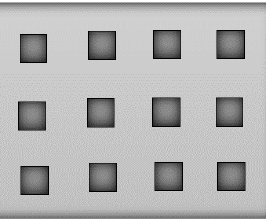
Figure 5. Schematic view of 200 nm diameter aperture arrays with 1 um period (adapted from the work in